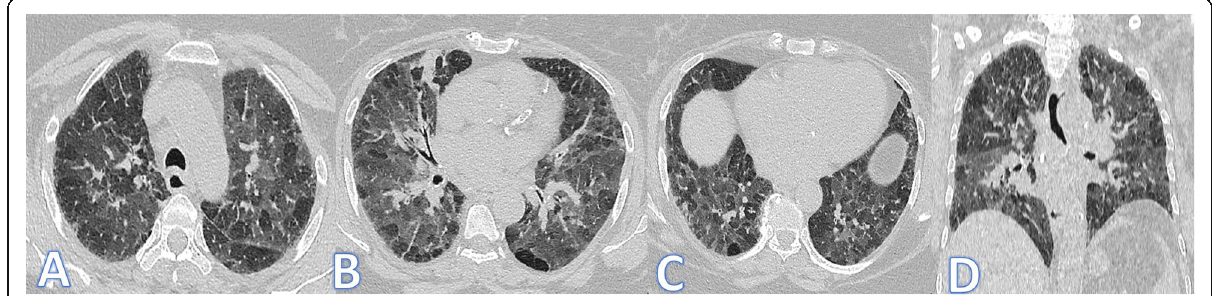
Fig. 9 A 64-year-old female axial and coronal CT image shows the headcheese sign, featuring sharp geographic margination along the edges of the secondary pulmonary lobules with three distinct levels of attenuation representing normal, ground glass, and hyperinflated regions of lung. The diagnosis was subacute